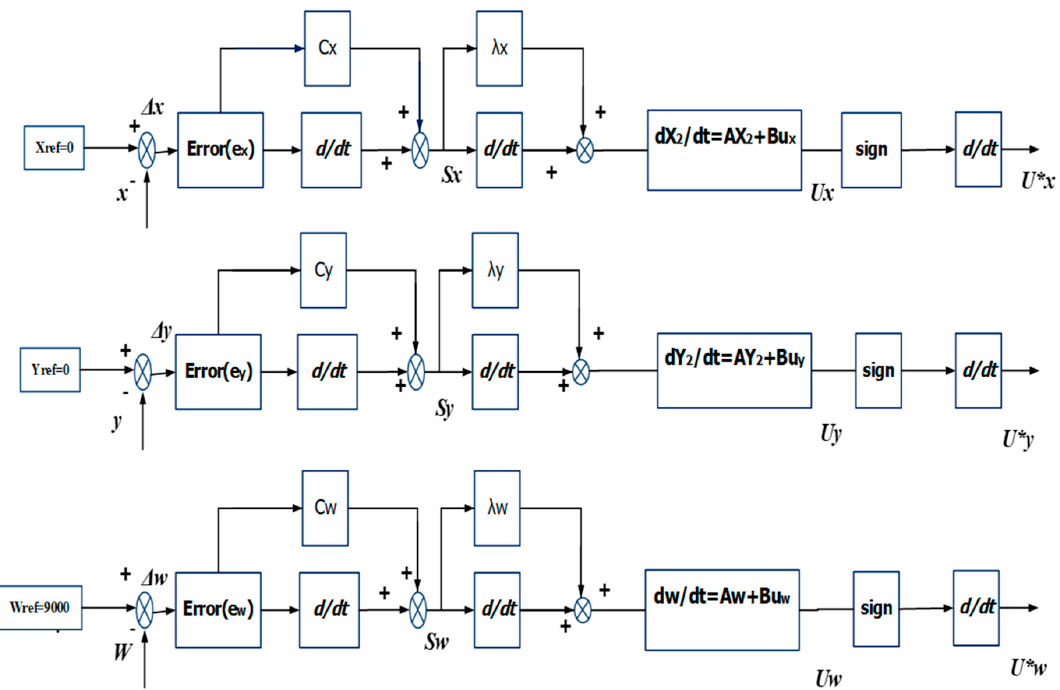
Figure 4. Block diagram of the dynamic sliding mode control.